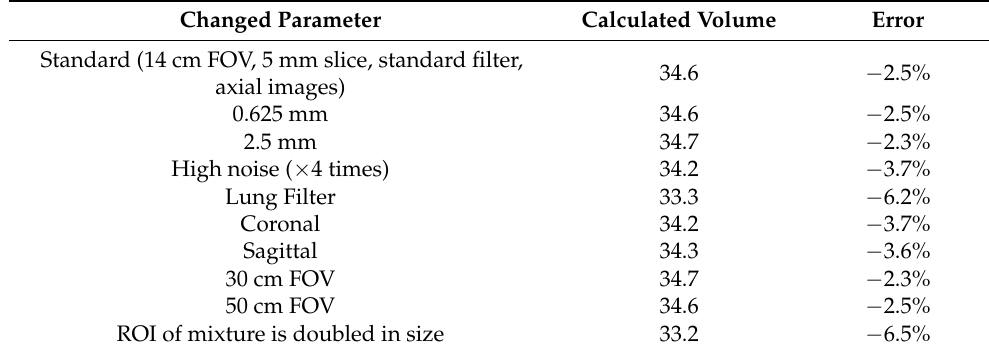
Table 1. Results of calculated volume with the standard parameters and with altered parameters. Changed Parameter Calculated Volume Error Standard (14 cm FOV, 5 mm slice, standard